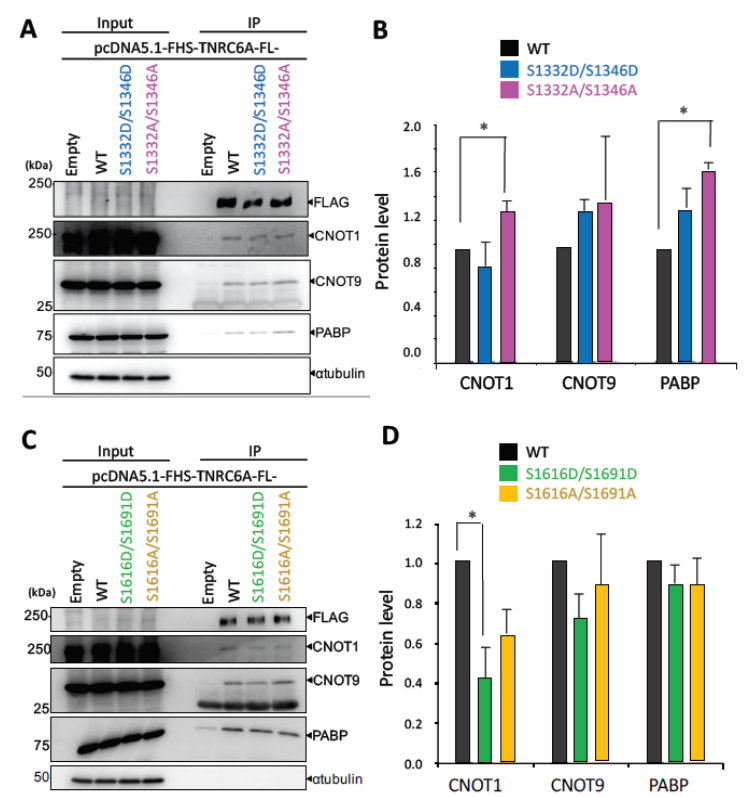
Figure 4. Effect of phosphorylation of full-length (FL) TNRC6A on the interaction with RNA silencing-related factors. ( A ) Immunoprecipitation using HeLa cells expressing FLAG-HA-SBP (FHS)-tagged WT TNRC6A-FL or TNRC6A with S1332D/S1346D or S1332A/S1346A was performed using anti-FLAG antibody. CNOT1, CNOT9, and PABP proteins were detected using anti-CNOT1, anti-CNOT9, and anti-PABP antibodies, respectively. α -tubulin was used as a negative control. ( B ) The signal intensities of CNOT1, CNOT9, and PABP proteins shown in ( A ) were measured using ImageJ, and quantified by dividing the signal intensities by anti-FLAG antibody. ( C ) Immunoprecipitation using the cells expressing FHS-tagged WT TNRC6A FL or TNRC6A with S1616D/S1691D or S1616A/S1691A was performed, and CNOT1, CNOT9, and PABP proteins were detected. ( D ) The signal intensities of CNOT1, CNOT9, and PABP proteins shown in ( C ) were measured, and quantified by dividing the signal intensities by anti-FLAG antibody. The data shown in ( B ) and ( D ) were averaged from two independent experiments. Each Western blot’s data are shown in Figure S2. * p < 0.05 (Student’s t -test).